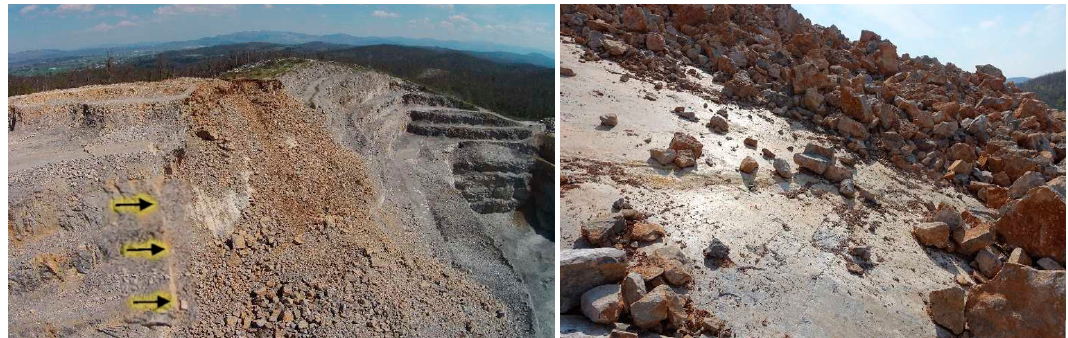
Figure 2. Left: view of the rockslide toward the southeast. A fault plane is clearly visible. Vertical cracks on the west side are noted with arrows. Right: the flat sliding surface in the rockslide area, facing east.